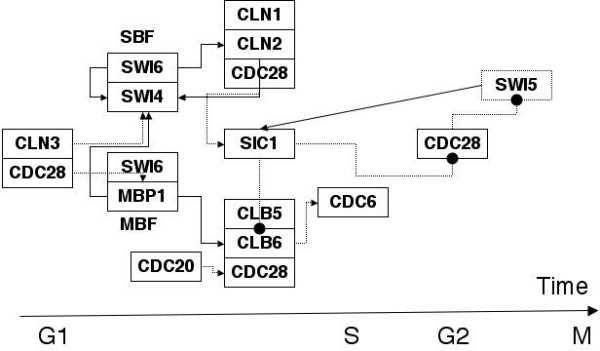
Known Yeast Cell Cycle Interactions. Schematic of known yeast cell cycle interactions between protein products of the twelve genes we studied (Table 1). An arrow indicates a positive interaction and a closed circle indicates a negative interaction. A dashed line indicates a protein-protein (e.g., phosphorylation, etc.) interaction and solid lines indicate direct transcriptional regulation. Genes are shown adjacent to each other when they are treated as a cluster in the KEGG pathway diagram (in the case of SBF and MBF the genes code for protein subunits). A connection inside a cluster indicates regulation of the whole cluster simultaneously. The interactions are located along an approximate time axis through the stages of the cell cycle (G1, S, G2).